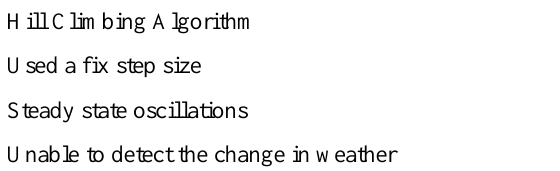
Comparison of Approaches of HC and OHC Algorithms Hill Climbing